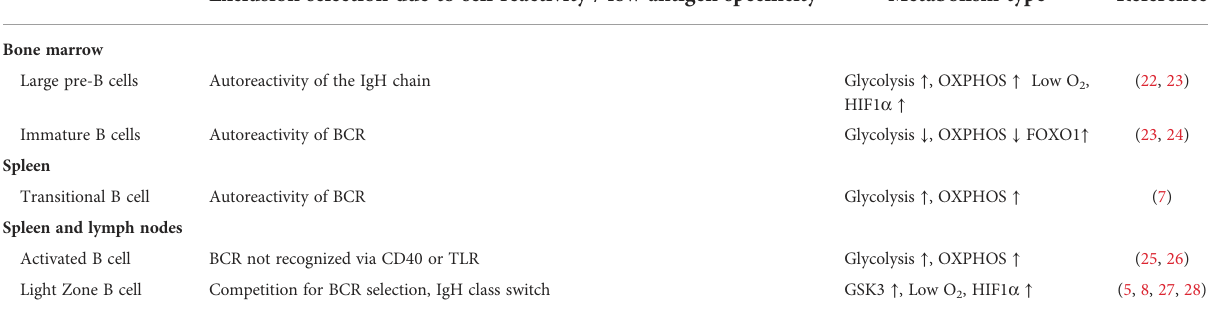
TABLE 2 Metabolism at B-cell stages where clones with low antigen speci fi city or self-reactivity are excluded. Exclusion selection due to self reactivity / low antigen speci fi